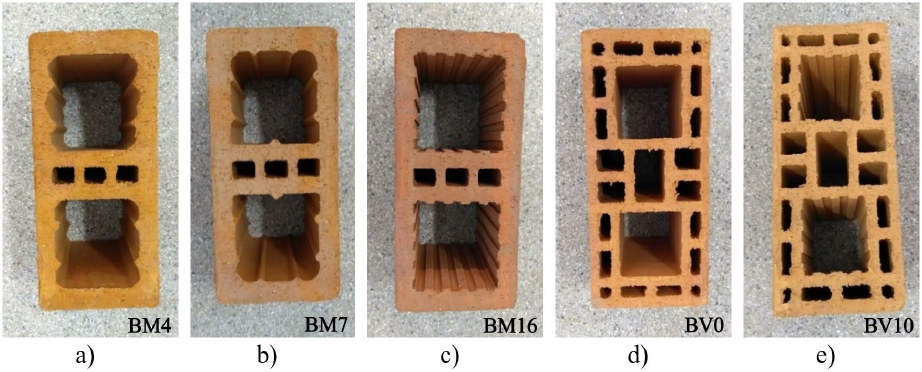
Figure 1. Types of fired clay blocks.